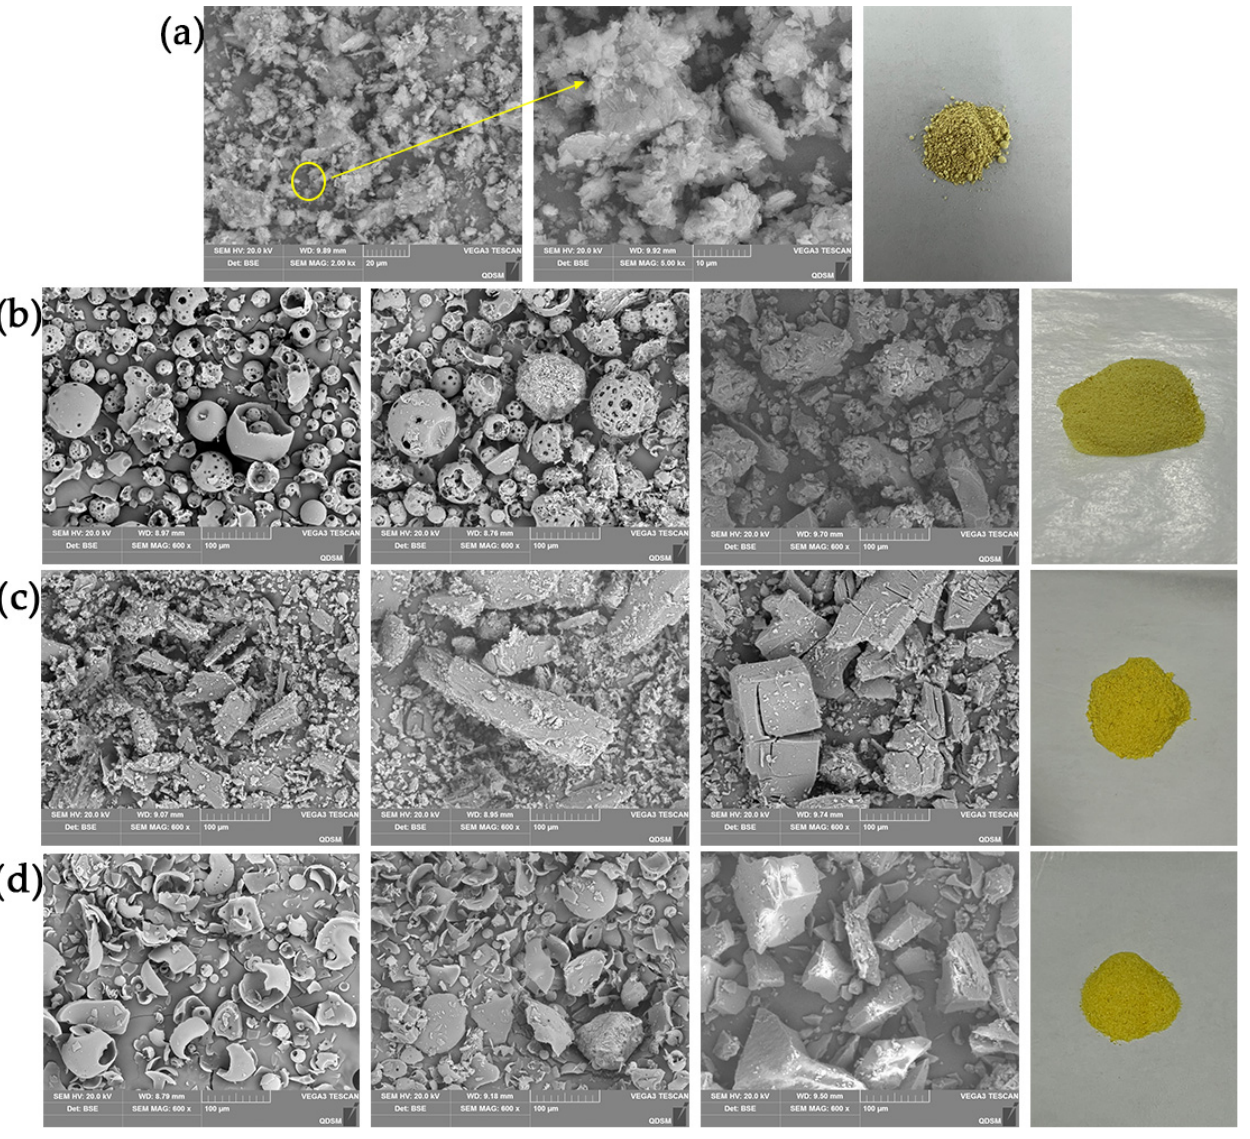
Figure 3. SEM image of Hyp with CD complex systems and their powder image. ( a ) Hyp (2000× and 5000× magnification) and powder image, ( b ) Hyp/2H- β -CD complex system, ( c ) Hyp/ β -CD complex system, ( d ) Hyp/M- β -CD complex system. From left to right: Cyclodextrin image (600× magnifica- tion), physical mixture image (600× magnification), IC image (600× magnification), and powder im- age.